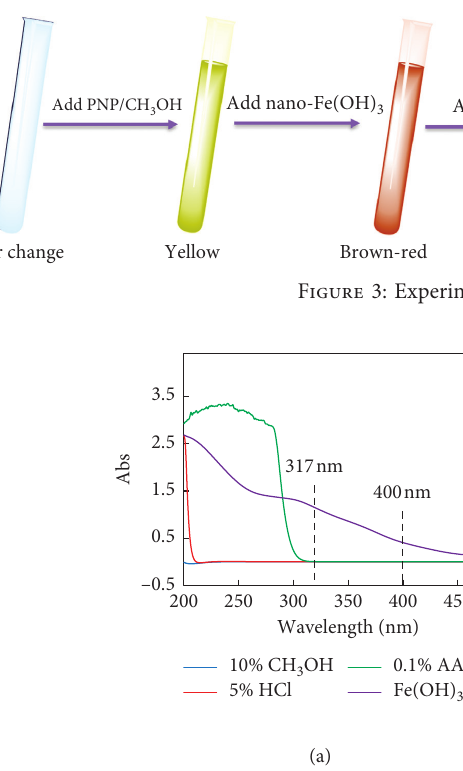
Figure 4: UV-Vis absorption spectra of (a) different reagents and (b) 20mg/L PNP under different pH.